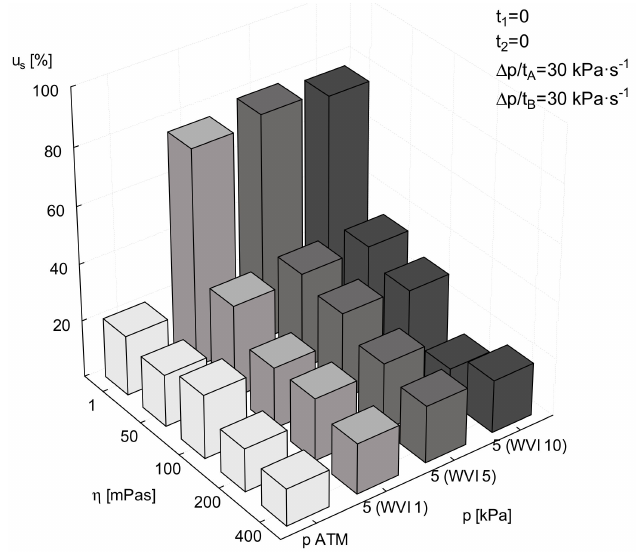
Figure 9. Percentage of apple tissue staining u s depending on the solution viscosity coe ffi cient in the di ff erent impregnation treatments, t 1 = t 2 = 0; pressure change rate—30kPa · s − 1 . 5(WVI 1)—onecycle of WVI at 5 kPa, 5(WVI 5)—fivecycles of WVI at 5 kPa, 5(WVI 10)—10 cycles of WVI at 5